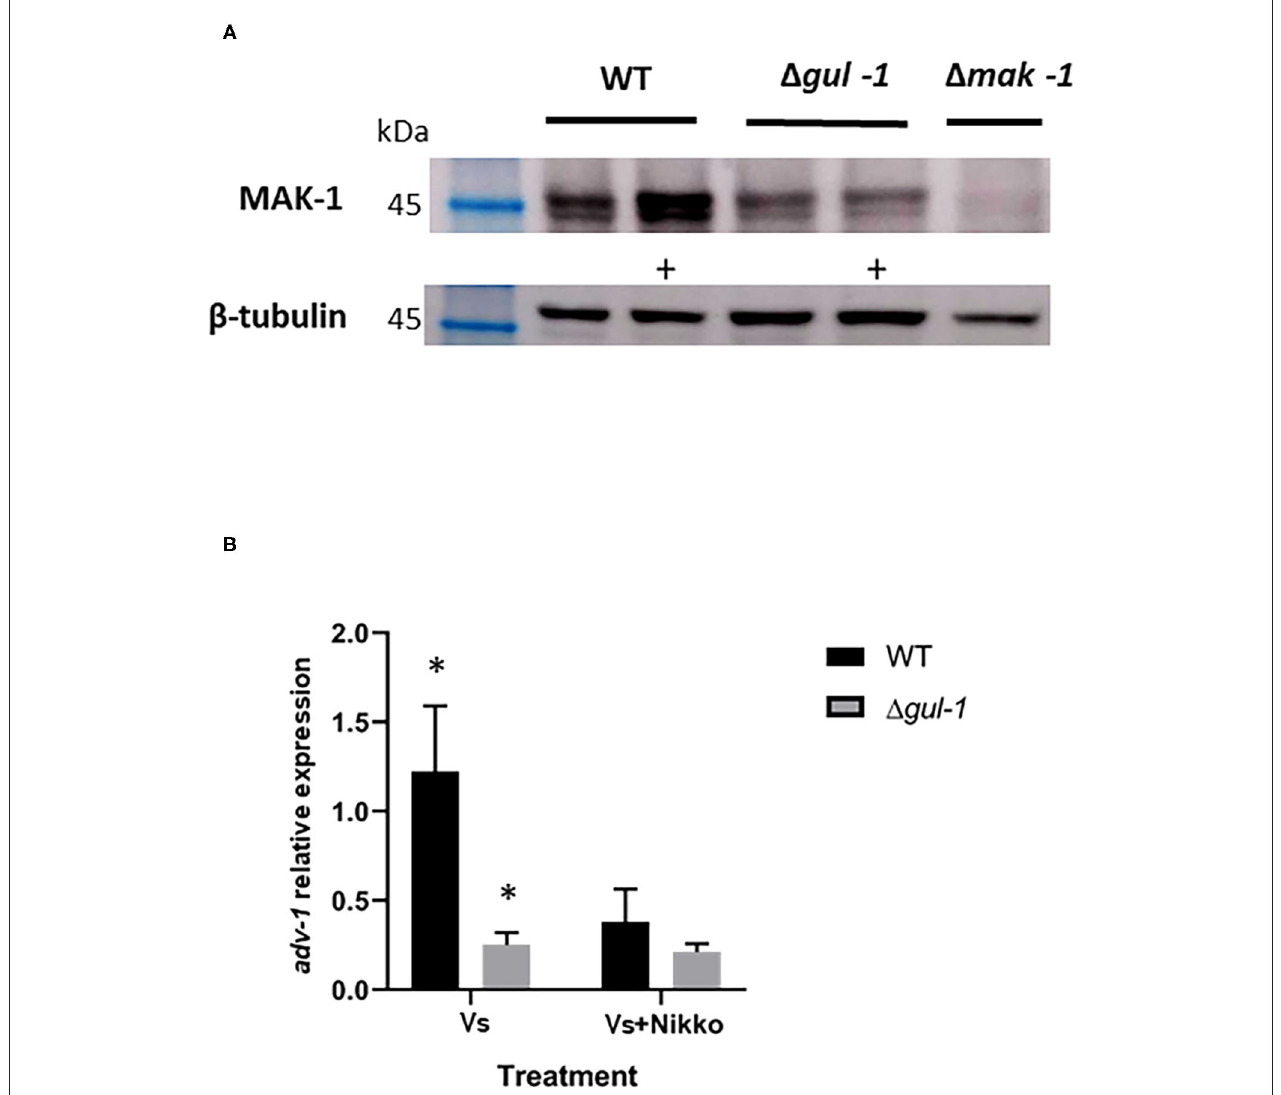
FIGURE 6 | GUL-1 is involved in regulation of the CWI pathway. (A) Phosphorylation states of MAK-1 (45 kDa), as determined by probing with anti-phospho p44/42 antibodies, in the wild-type, 1 gul-1 , and 1 mak-1 strains under standard growth conditions and 1h following medium amendment with the chitin synthase inhibitor Nikkomycin Z 10 − 5 M (marked + ). β -tubulin (50 kDa) was used as a reference protein. (B) Expression profiles of adv-1 in the wild-type and 1 gul-1 strains as determined by RT PCR under standard growth conditions and 1h following medium amendment with Nikkomycin Z (10 − 5 M). The relative expression level of the